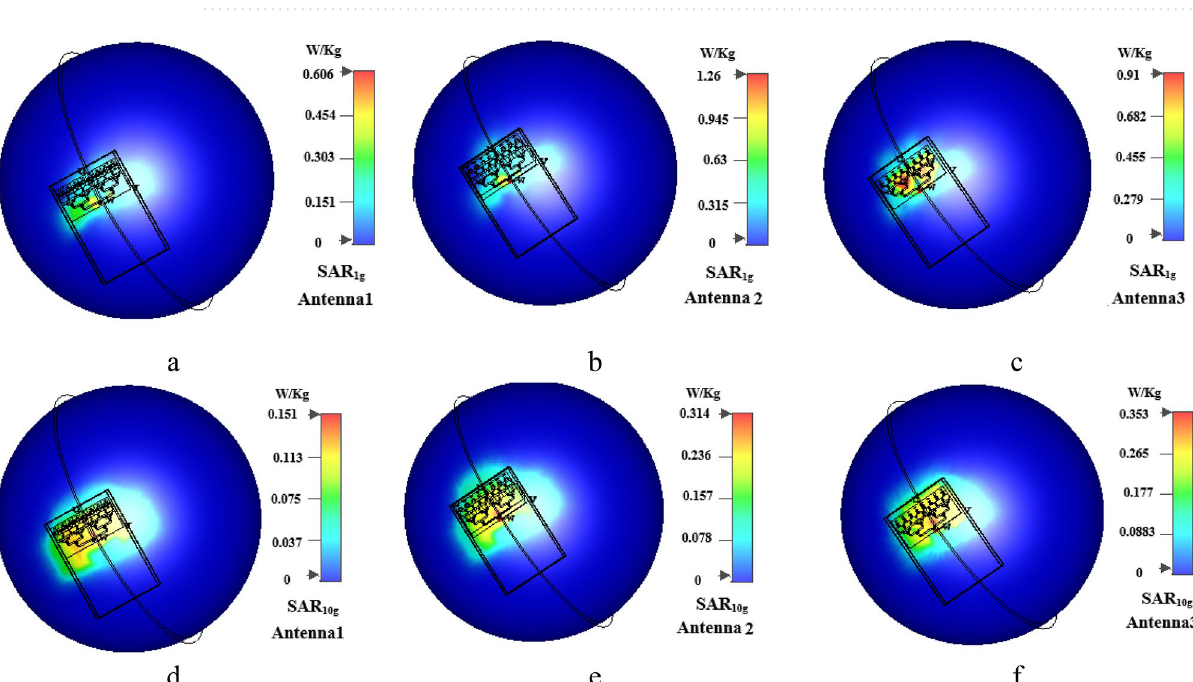
Figure 8. Simulated SAR parameter of antenna1 (SAR 1g ( a ), SAR 10g ( d )), antenna2 (SAR 1g ( b ), SAR 10g ( e )) and antenna3 (SAR 1g ( c ), SAR 10g ( f